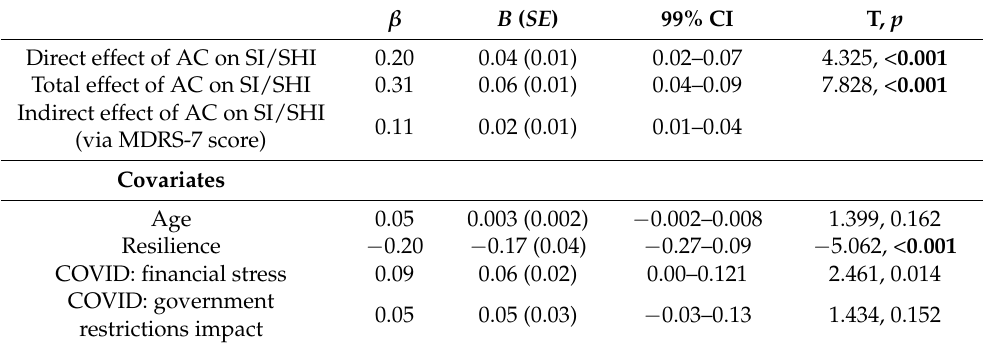
Table 4. Mediation model assessing the mediating role of male-type depression in the relationship between avoidant coping and suicidal/self-harm ideation ( n =